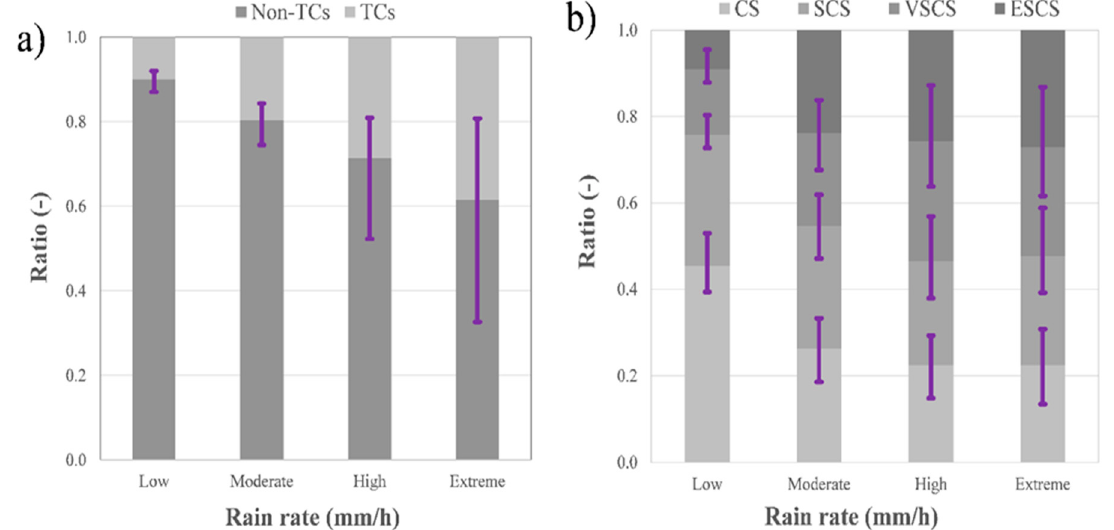
Figure 13. Land-Ocean variability for ( a ) Non-TC and TC, ( b ) TCs intensity groups. Rain rate has been categorized into low (0–1 mm / h), moderate (1–10 mm / h), high (10–20 mm / h), and extreme ( > 20 mm / h) for the entire domain (land / ocean). The vertical bar denotes the land (upper value) / ocean (lower value) variability.